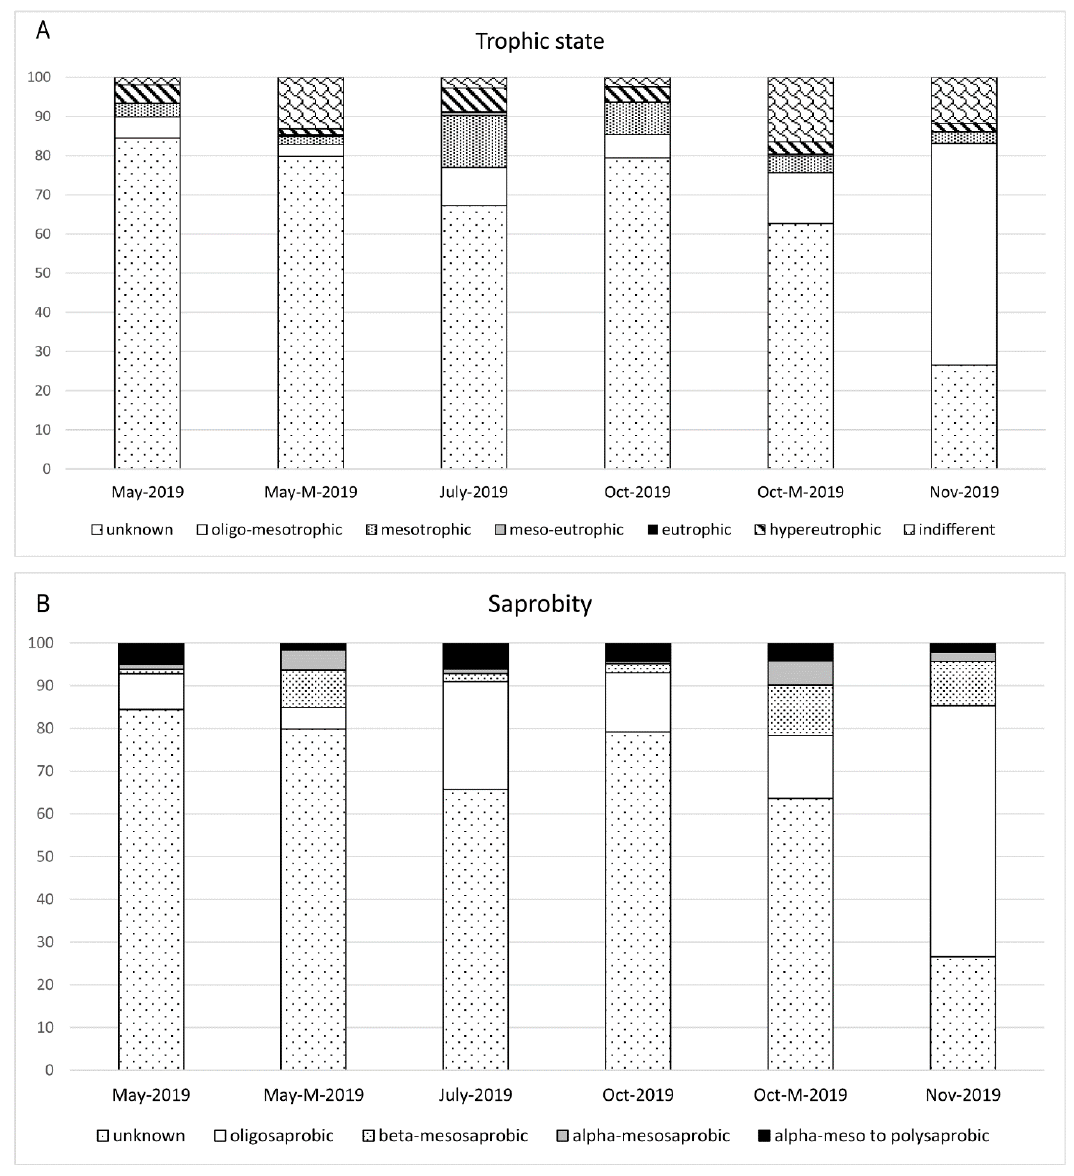
Figure 9. Ecological traits retained: trophic state ( A ) and saprobity ( B ) obtained in 2019 (M = macrophytes).